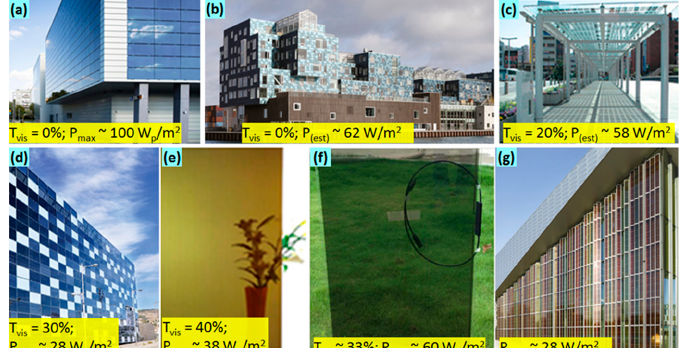
Figure 2. Conventional (building-applied photovoltaics (BAPV)), colour-optimised, and semitransparent commercially available BIPV technologies at a glance. ( a ) Avancis PowerMax Skala CuInSe 2 panels [50]; ( b ) Multilayer-coated, colour-optimised BIPV facade by EPFL (Ecole Polytechnique Federale de Lausanne, Switzerland) and Emirates Insolaire [27,28,33]; ( c ) AGC (Asahi Glass Corporation, Japan) Sunjoule product [51]; ( d ) Onyx Solar a-Si high-transparency BIPV panels [52]; ( e ) Hanergy BIPV panels using a-Si [53]; ( f ) High-transparency CdTe BIPV panels [35]; ( g ) Solaronix BIPV façade based on semi-transparent dye-sensitised solar cells [34,54]; the methodology used for making the estimates of electric output is described in